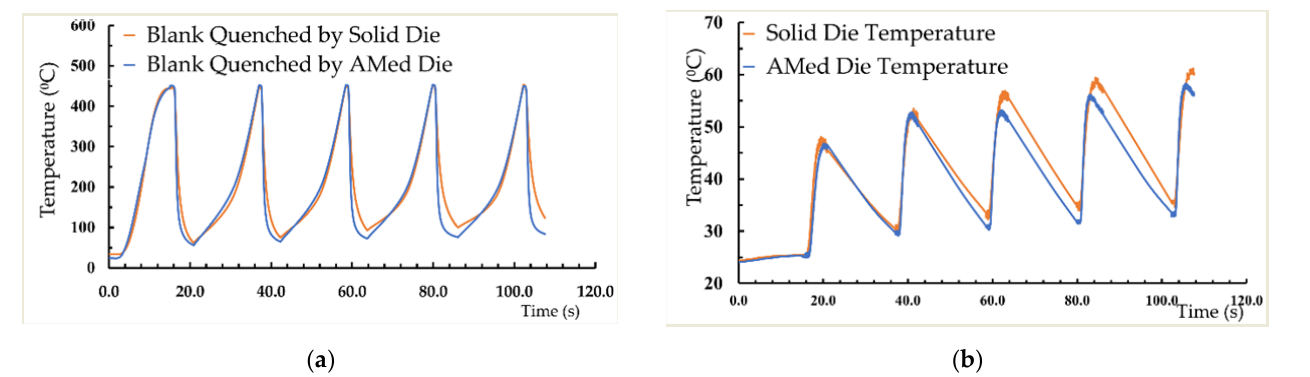
Figure 5 . ( a ) Temperature evolution of the blank; ( b ) temperature evolution of each die .